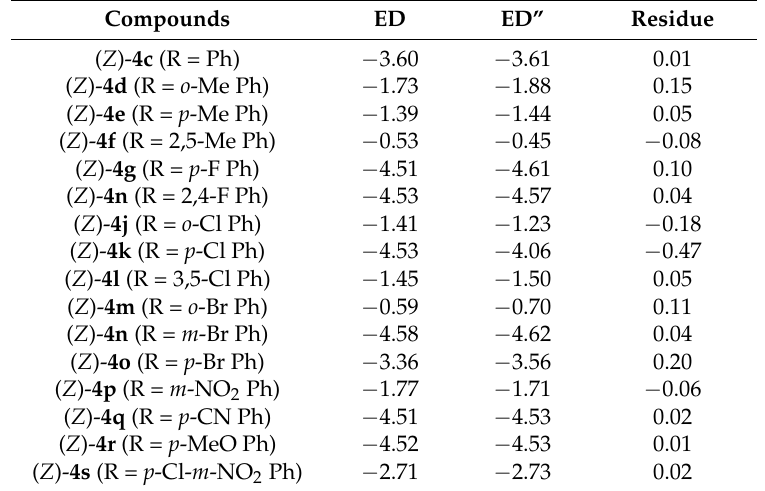
Table 2. The ED values of experimental and predicted activities.